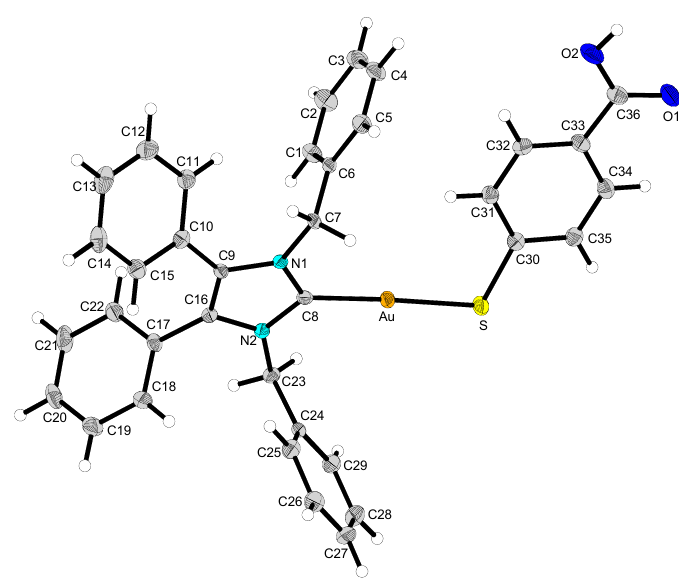
Figure 4. X-ray diffraction structure of 12 ; thermal ellipsoids are drawn on the 50% probability level. The Au–C(8) bond lengths of 2.031(8) Å for 2 , 2.012(3) Å for 12 , 2.008(2) Å for 13 and 2.008(3) Å